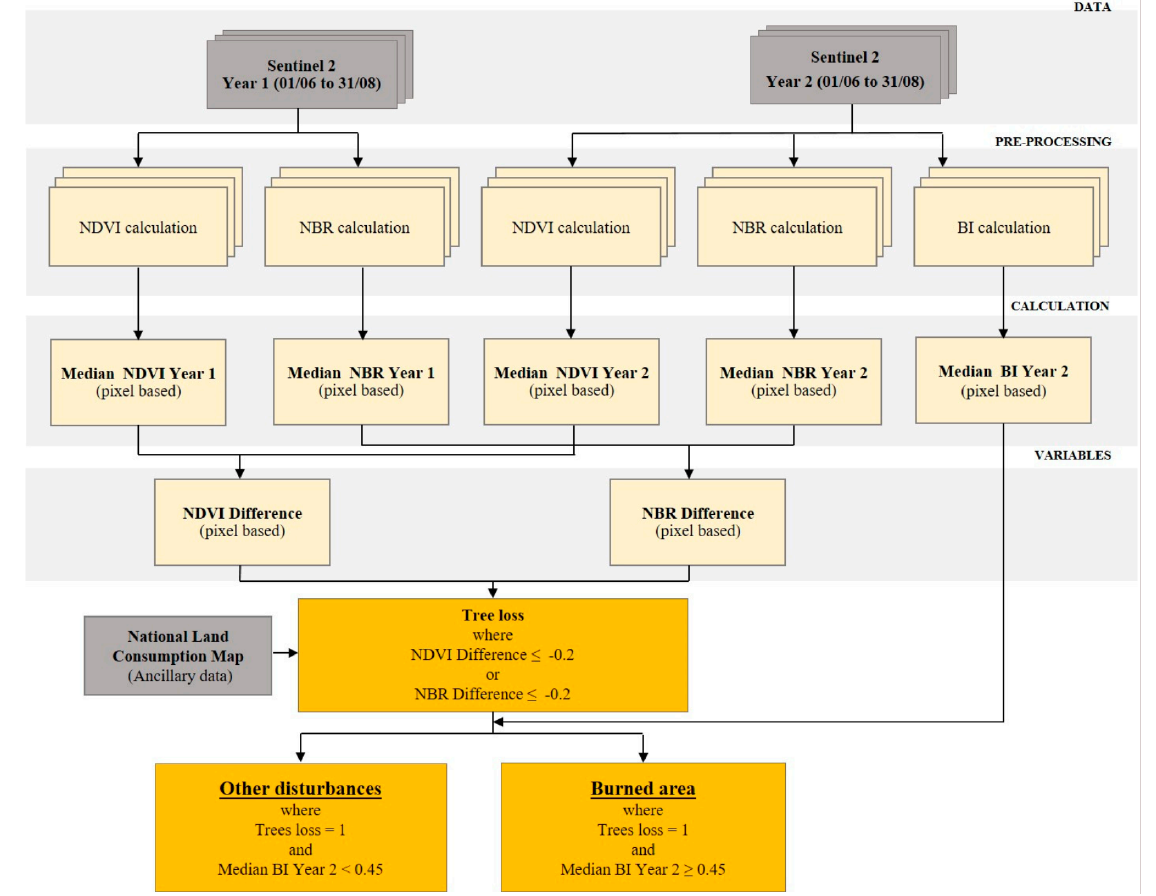
Figure A5. Workflow for forest disturbance